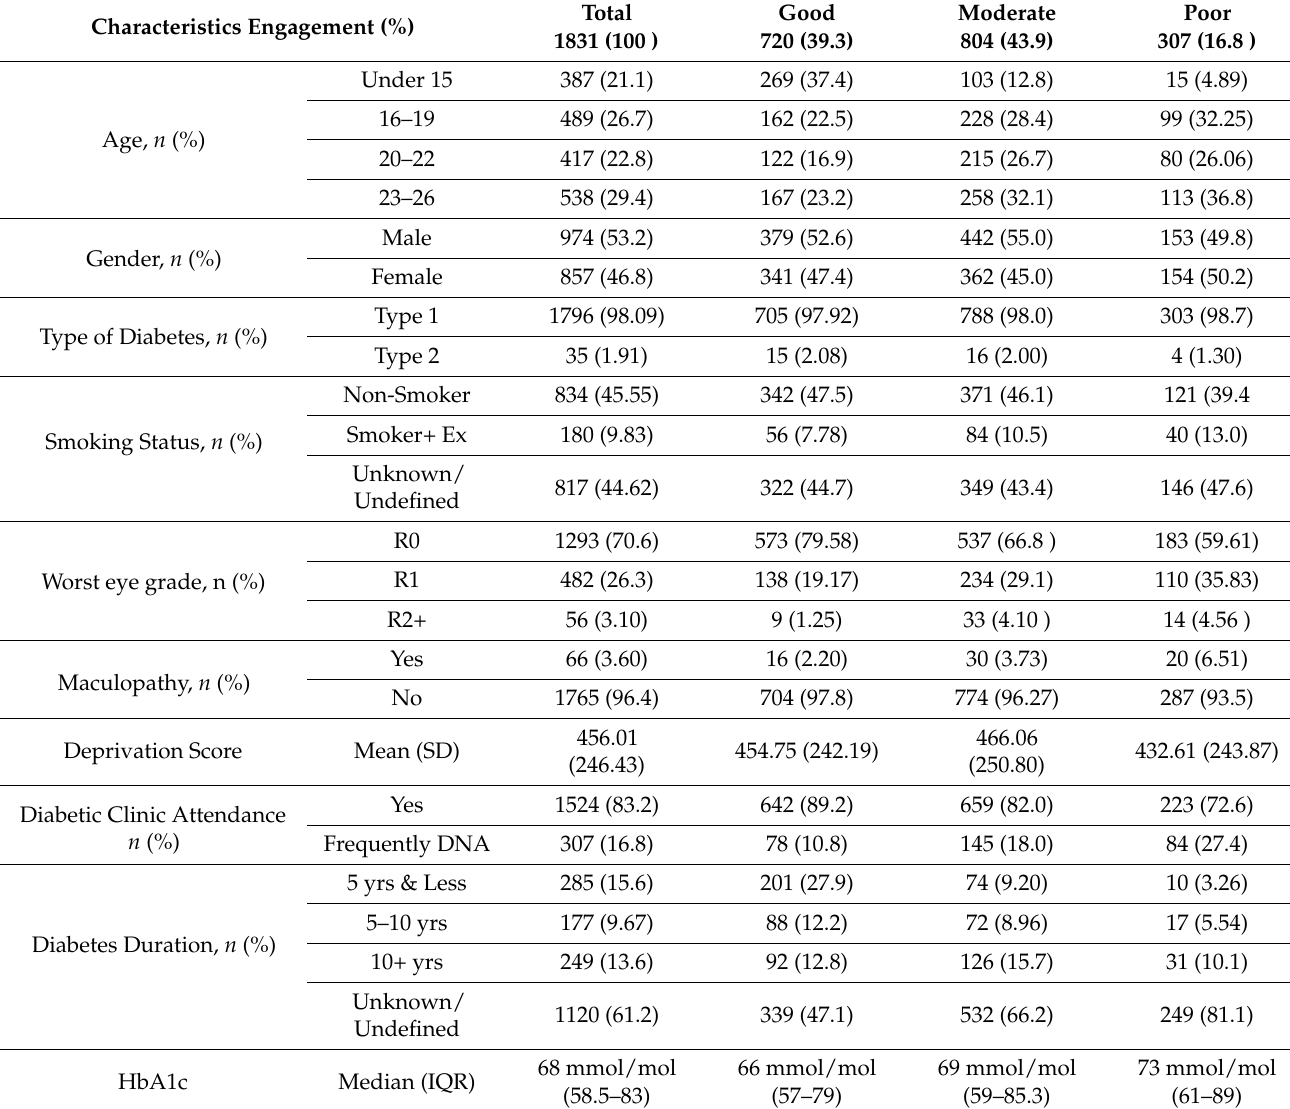
Table 1. Characteristics of patients attending Diabetic Eye Screening Service stratified by engagement index ( n = 1831). Characteristics Engagement